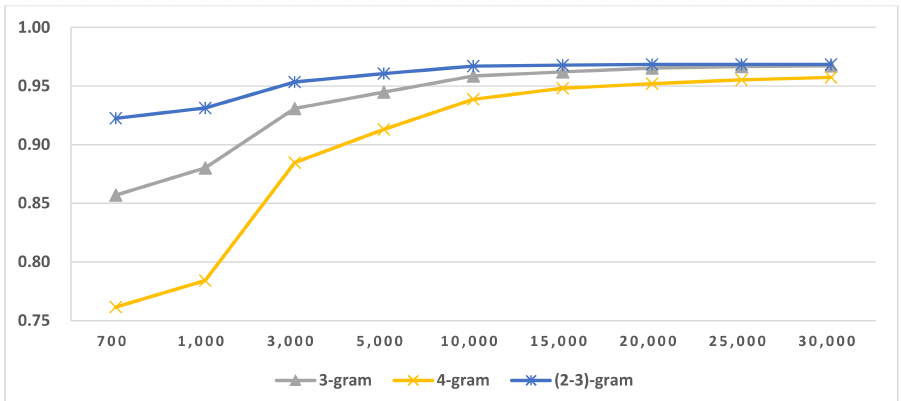
Figure 18. LI in Austronesian/Malayo-Polynesian (MP) in Latin script languages.